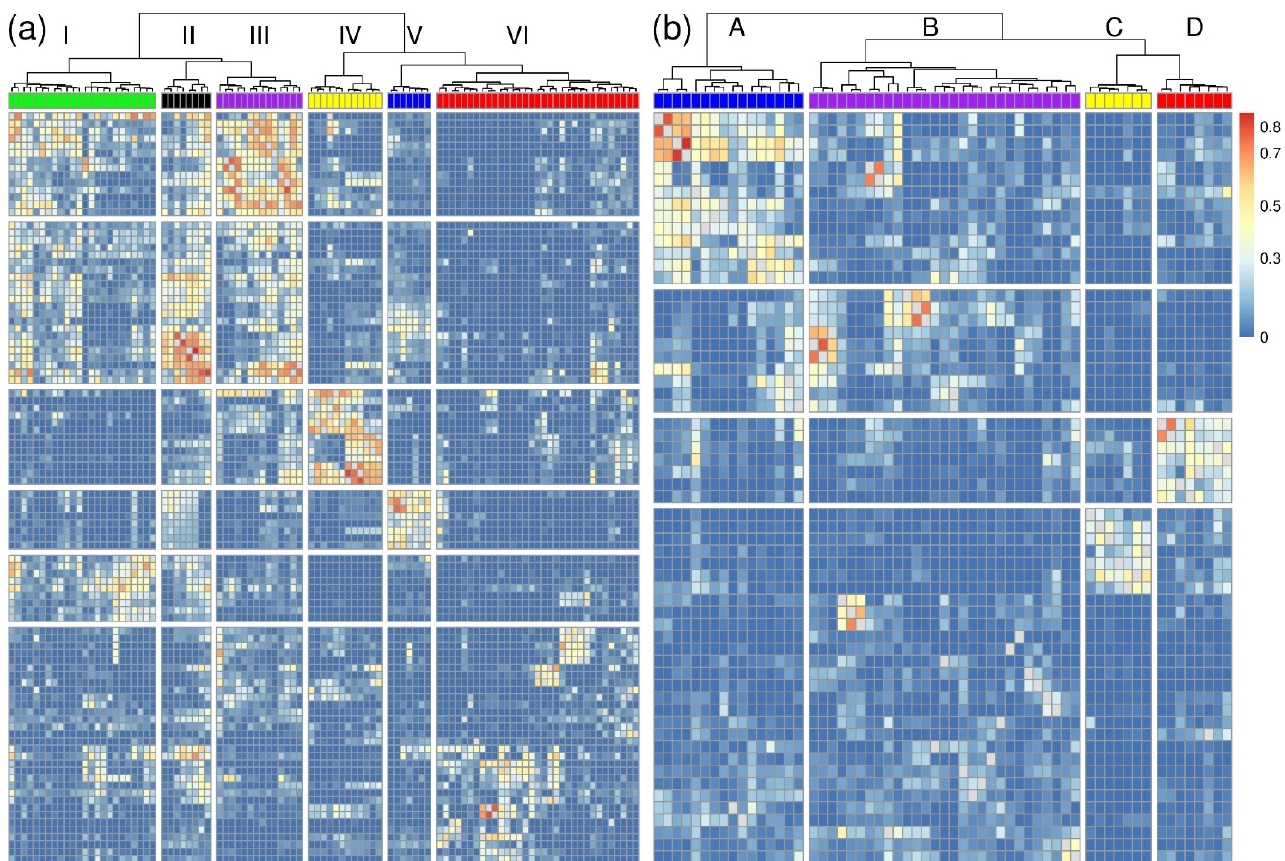
Figure 3. Results of the relation analysis of selected features with SMD for the determination of geographical origin ( a ) and botanical variety ( b ). For the hierarchical cluster analyses, Euclidean distances and Ward algorithm were applied and the clusters are labeled with I–VI and A–D. The clusters were assigned to the following molecular groups: I: Triaclyglycerols, II: Oxylipins, III: acylated monogalactosyldiacylglycerols, IV: Phytosterol esters, V: Triacylglycerols, VI: Various, A: Cycloartenol derivates, B: Coenzymes Q9 and Q10, C: Stigmasterol derivates, D: Diacylglycerols.